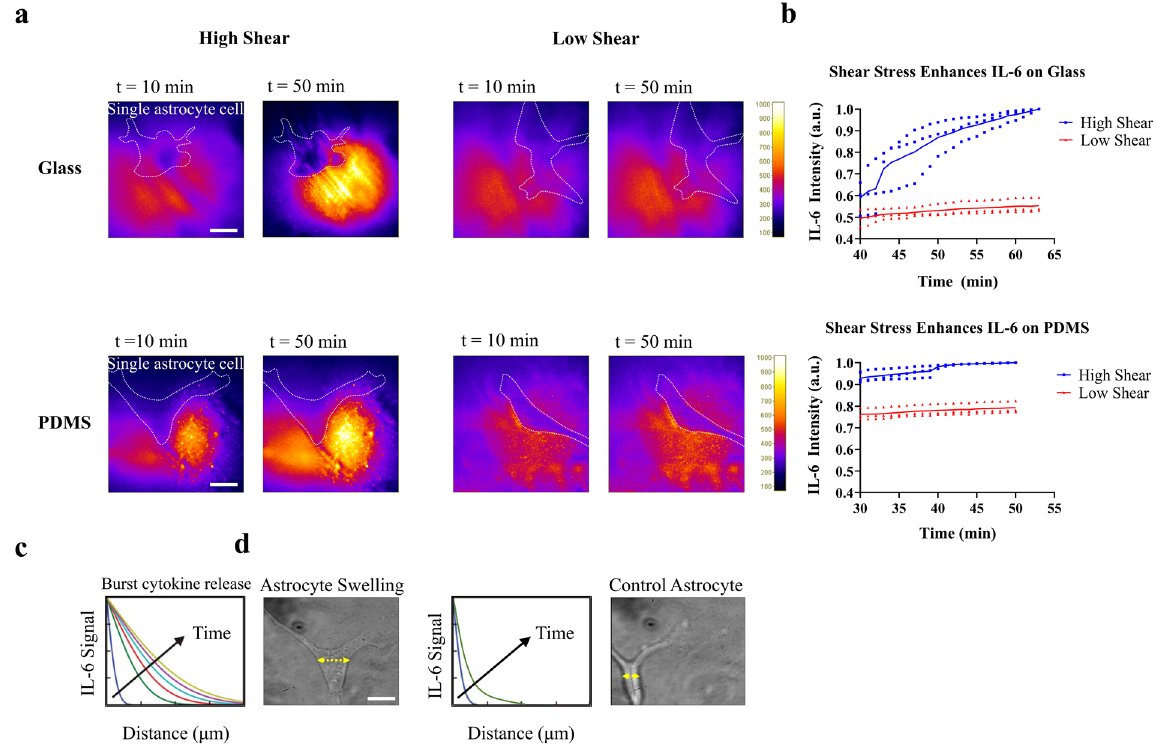
Fig. 4 Spatial-temporal mapping of secreted cytokines from single astrocyte cells upon shear stress on different substrates. a Quantitative spatial- temporal resolution mapping of IL-6 concentration under low and high shear stress at time 10 and 50 min, on glass and PDMS substrates. b Time course of the average intensity of IL-6 signals under low and high shear. The results are represented as individual data points in the plots and the solid line denotes the average value. Data were normalized via dividing by the maximum value to bring all the measured values in the dataset to the same metric scale. Independent experiments were performed on three different devices ( n = 3) per substrate. c Representative measures depicting spatial-temporal mapping of IL-6 signal dependent on distance from astrocytes for a duration of 50 min. d Bright fi eld image of resting and high shear-cytokine activated single astrocyte cell, characterized by horizontally swollen bodies. The cross-sectional area was calculated using a line drawn to measure the diameter of astrocyte boundary. Single astrocyte cells were identi fi ed and localized in individual image frames. Scale bars represent 10 µ population of astrocytes attached on the surface, instead of single astrocytes (Fig. 5a). In accordance with our TIR-FM data, ELISpot data con fi rm that under high shear stress, despite less cell attachment on both glass and PDMS substrates compared to low shear stress, a signi fi cant ( p = 0.0056 and p = 0.0005, respec- tively) increase in IL-6 secretion was detected (Fig. 5b).